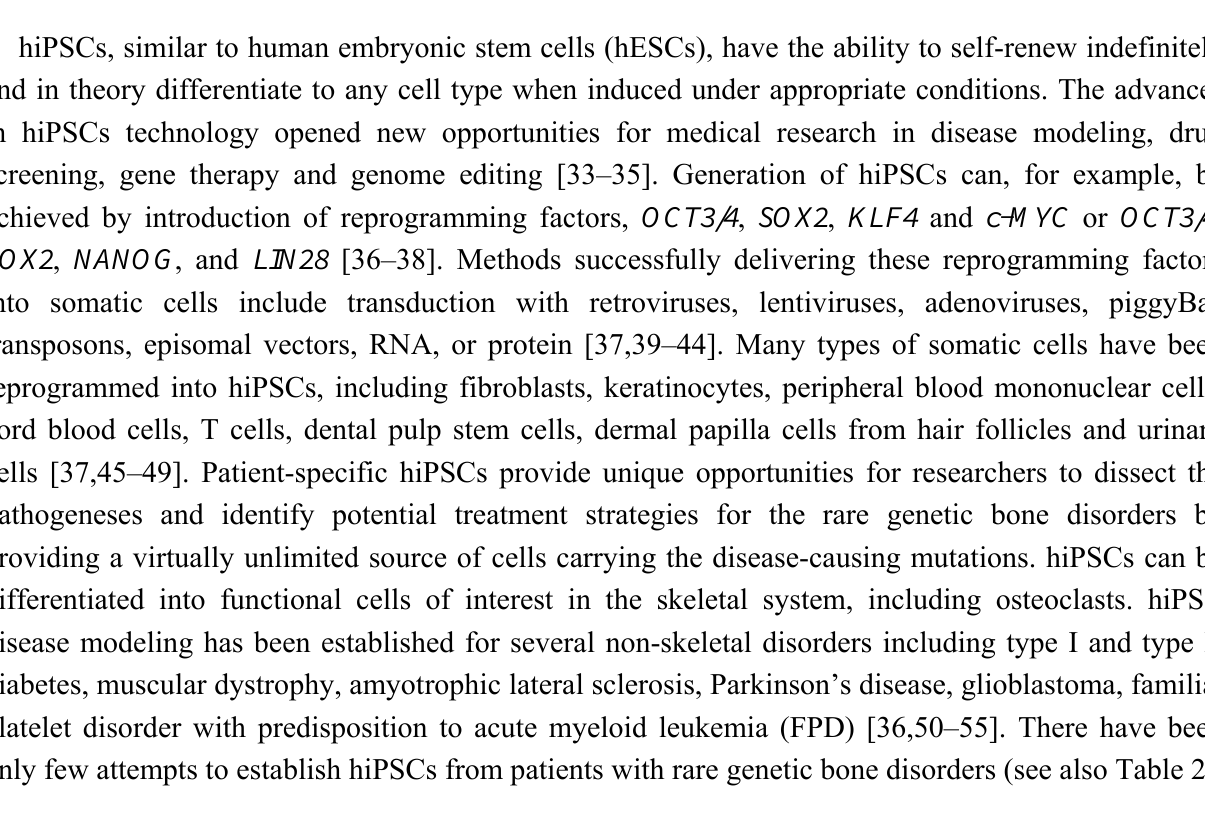
Table 2. iPSCs generated from patients with rare genetic bone